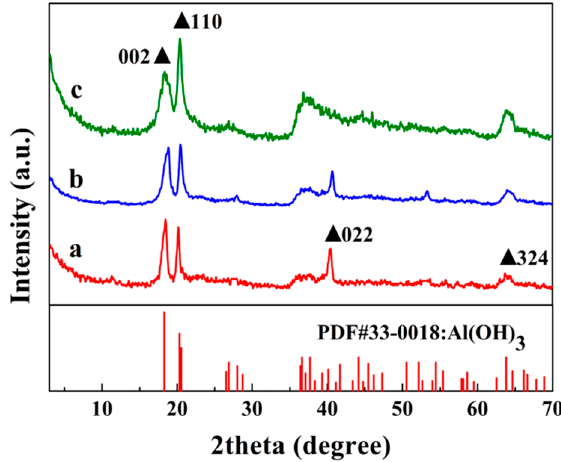
Figure 3. XRD patterns of solid products after lithium recovery from LiAl-LDHs at varied initial Li + concentrations ( a ) 6.75 g/L, ( b ) 3.375 g/L, ( c ) 1.6875 g/L ( ▲ Al(OH) 3 ).